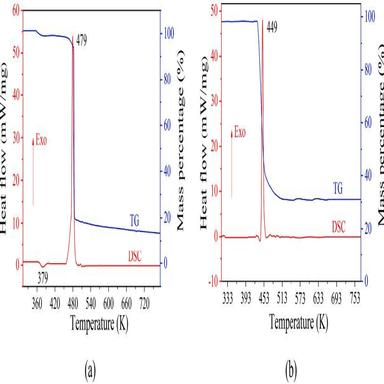
(a) TG-DSC curves for 2. (b) TG - DSC curves for 3.